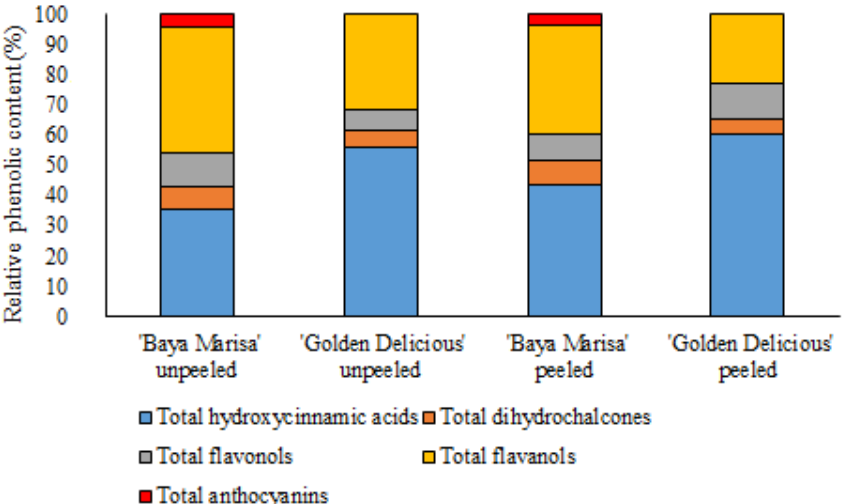
Figure 2. Relative content of identified phenolic compounds in unpeeled and peeled apple ( Malus domestica Borkh.) slices of cultivars ‘Baya Marisa’ and ‘Golden